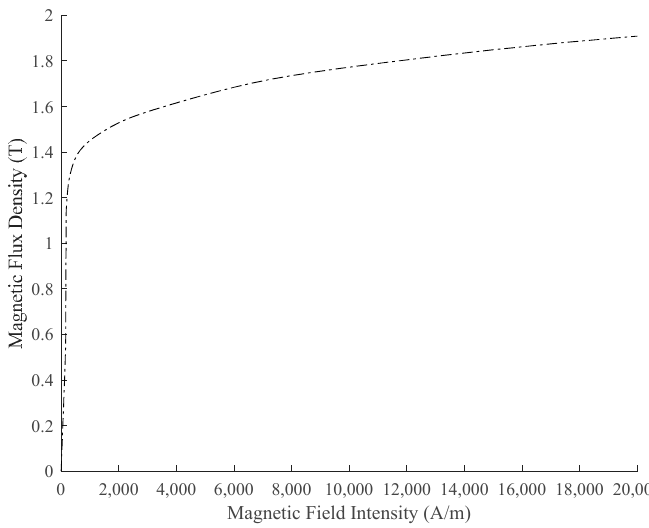
Figure 6. B-H curve of silicon steel.